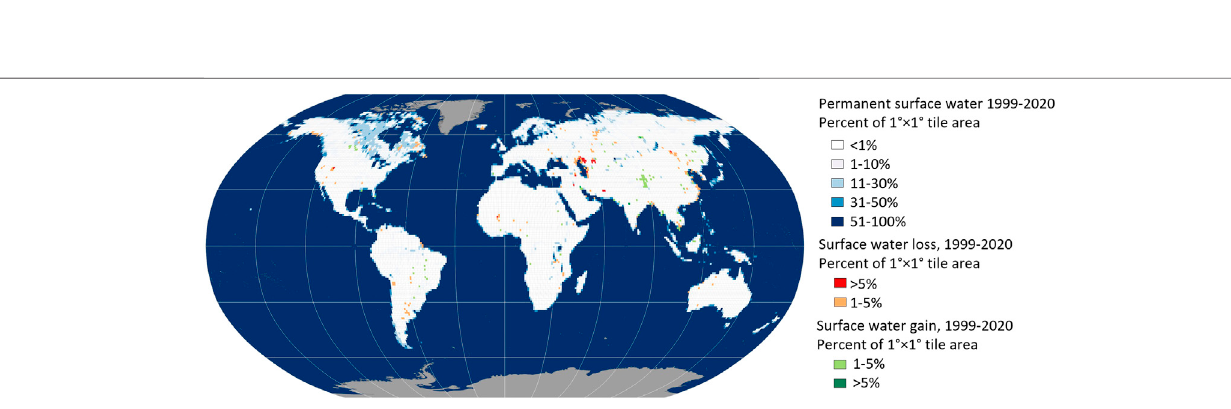
FIGURE 6 | Surface water extent and unidirectional dynamics, 1999 – 2020.